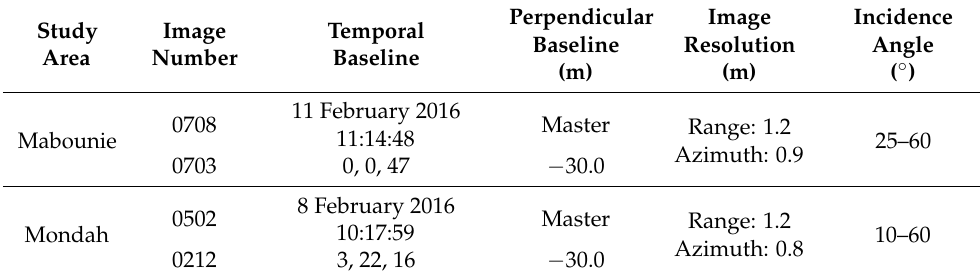
Table 1. System parameters for Mabounie and Mondah from the AfriSAR 2016